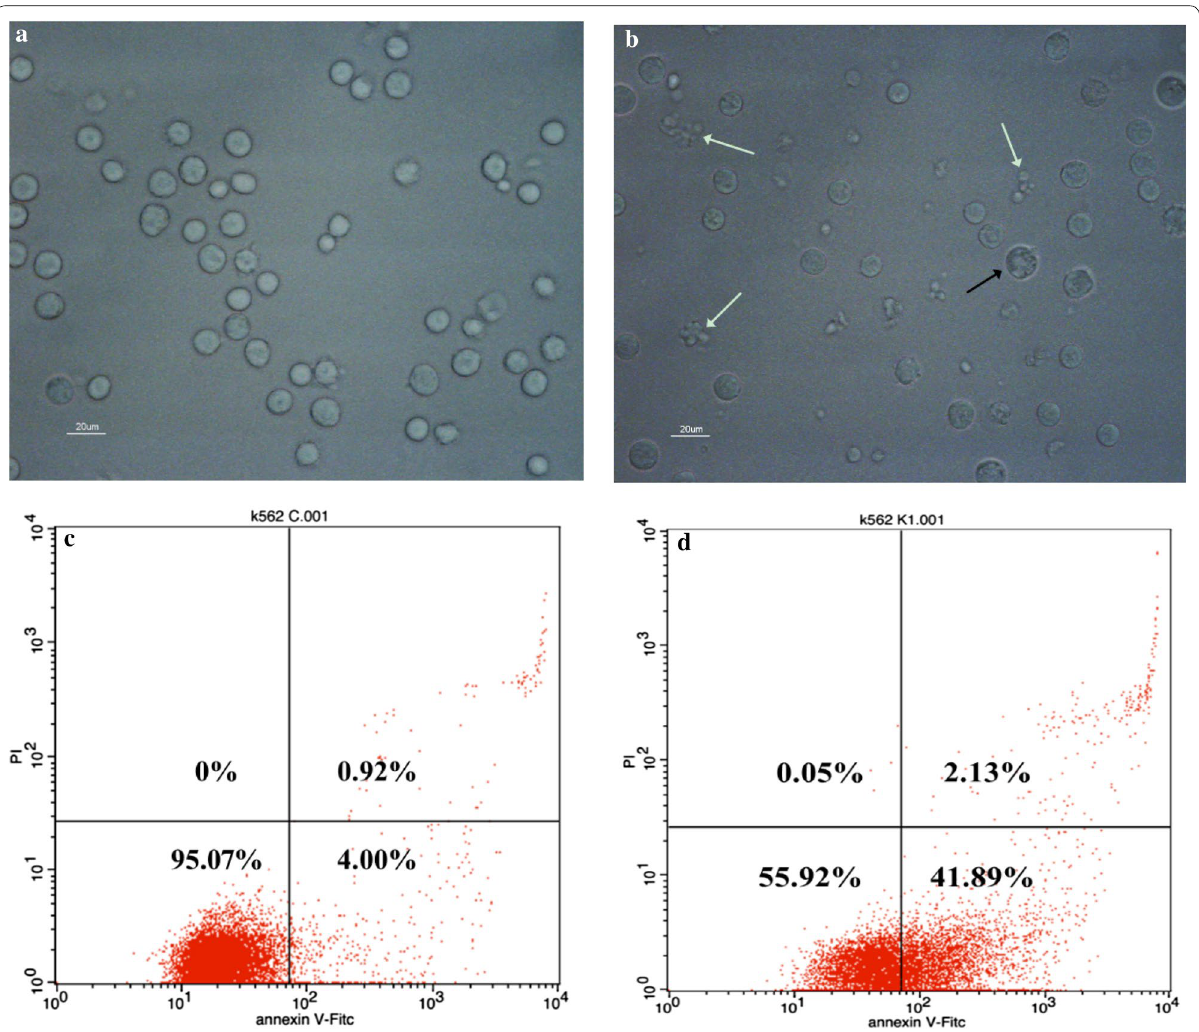
Fig. 3 Micrographs and flow cytometry analysis of K562. The samples were measured after 48 h without ( a , c ) and with ( b , d ) treatment of 65.76 μM lipopeptides. a , b The white arrows indicate cells exhibiting the typical phenomena of apoptosis, with membrane blebbing, apoptotic membrane protrusions, and apoptosis bodies. The black arrow indicates the cells exhibiting paraptosis phenomena. The scale bar is 20 μm. c , d The proportion of apoptotic cells increased